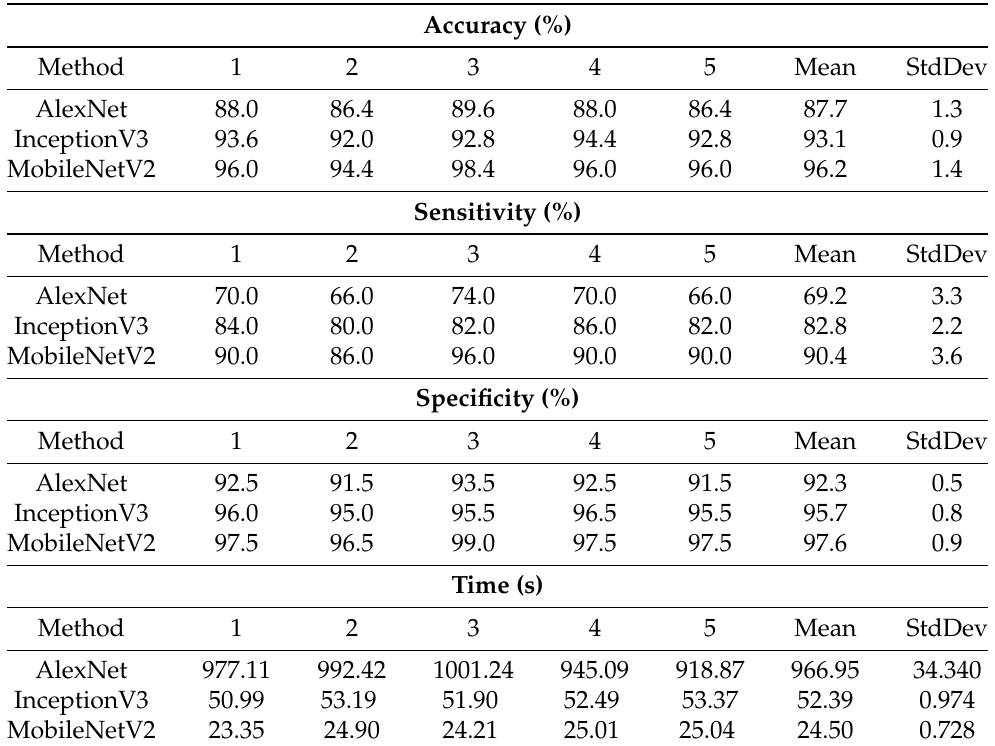
Figure 3. The confusion matrix of the multi-class classification results by MobileNetV2 on the test dataset. The class labels: 0 for healthy control, 1 for glaucoma, 2 for pathological myopia, 3 for maculopathy, and 4 for retinitis pigmentosa. Table 1. Experimental results of five independent runs from the three